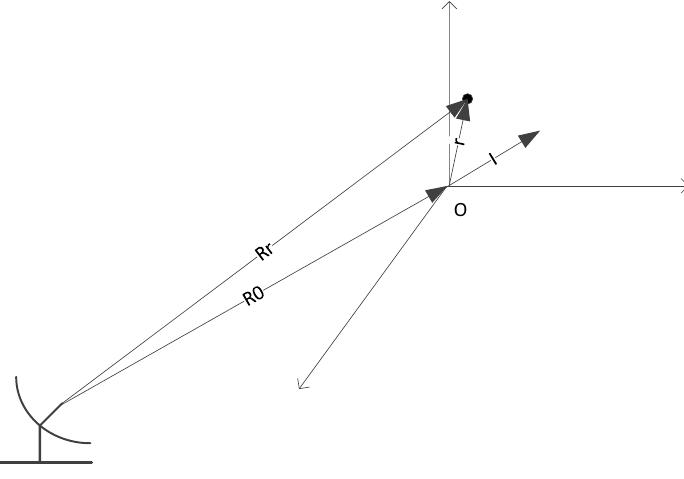
Figure 1. Schematic diagram of radar and target.